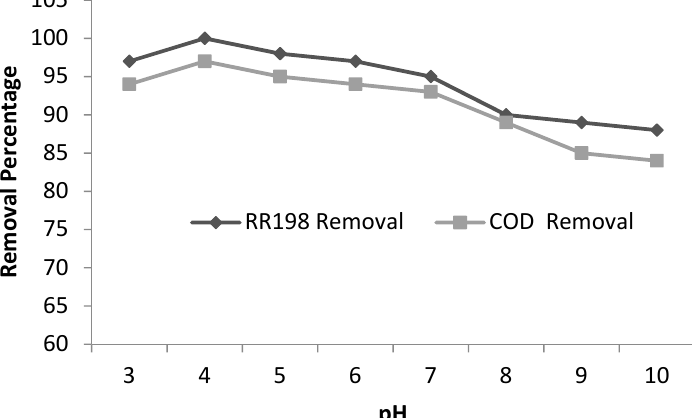
Figure 5. Effect of pH on RR198 degradation efficiency and chemical oxygen demand (COD) removal, optimum conditions: [RR198= 25 mg/L, catalyst dosage = 0.3 g/L, Persulfate (PS) = 5 mM, and reaction time: 25 min].